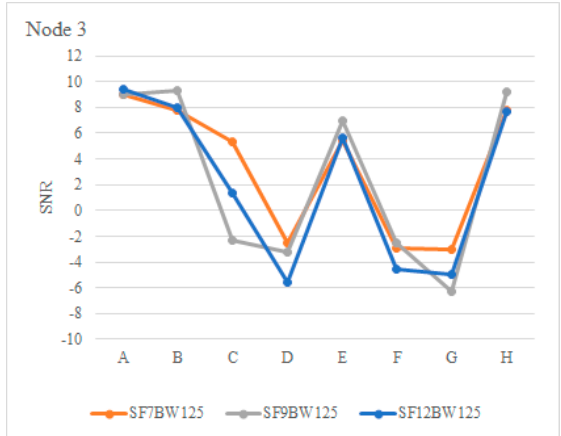
Figure 16. SNR of node